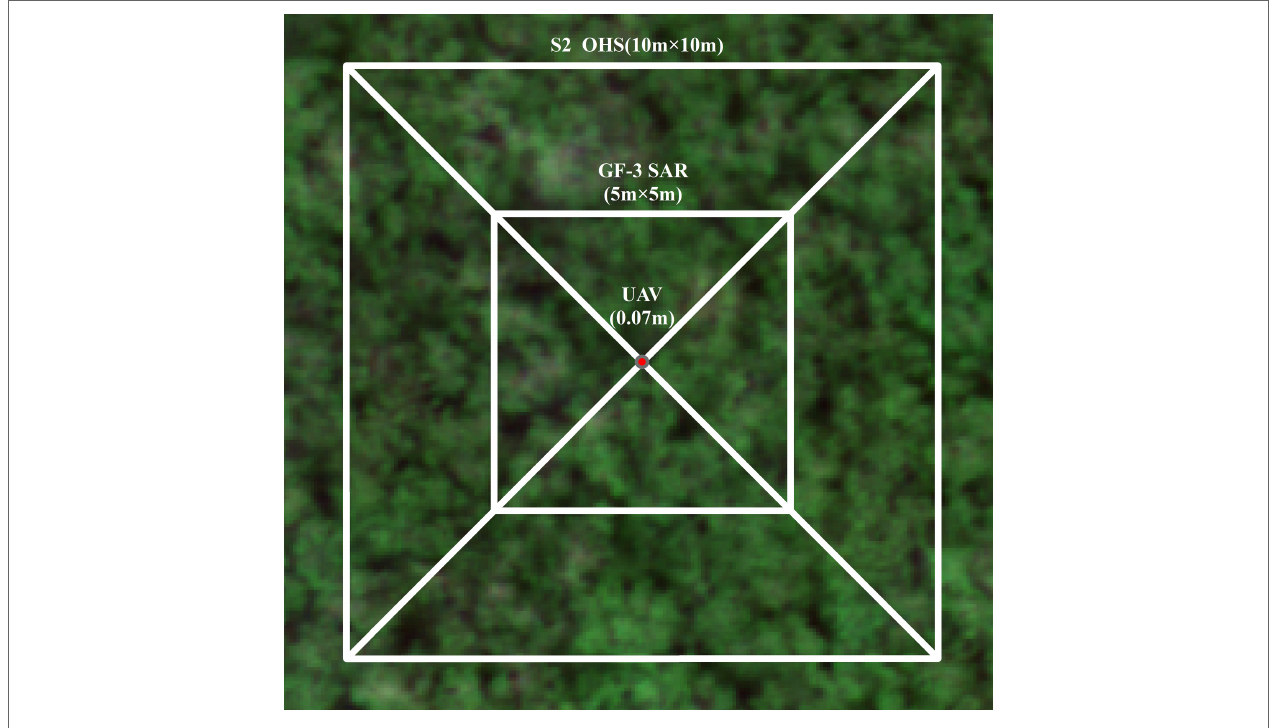
FIGURE 2 | Measurement method of multi-scale plots